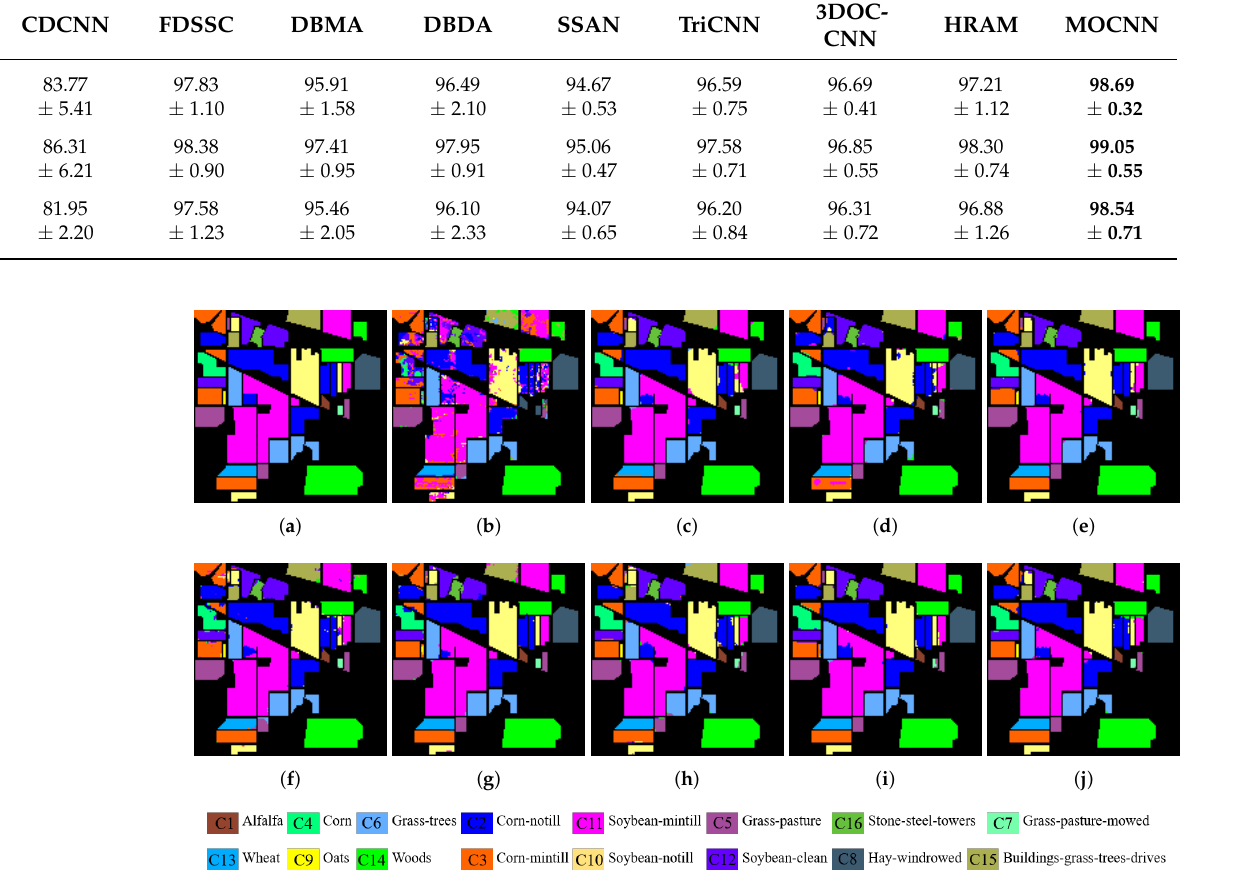
Figure 9. Map of the classification results from all approaches on IN. ( a ) Ground truth. ( b ) CD-